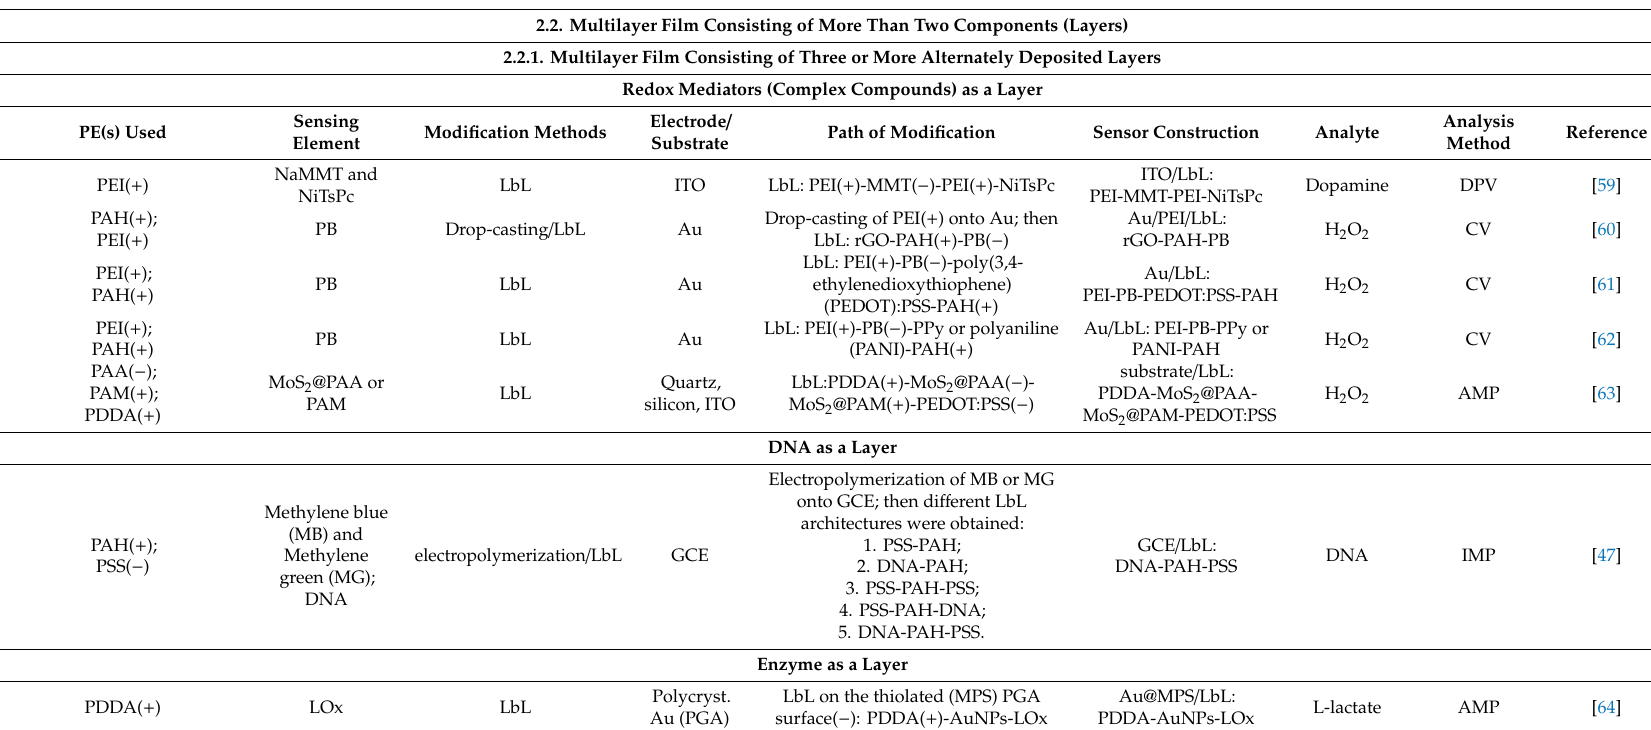
Table 2. Summary view of electrochemical sensors based on multilayer sensing films, obtained by LbL, consisting of more than two